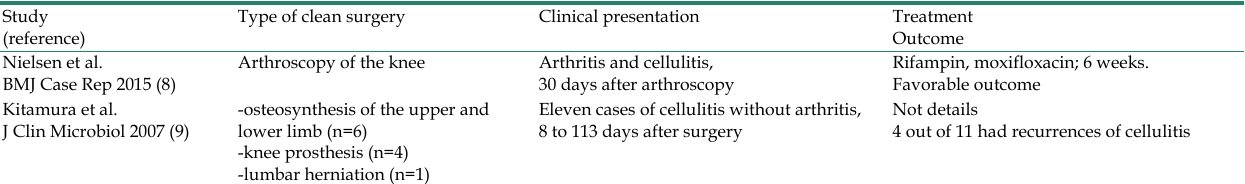
Table 2: Cases of postoperative Helicobacter cinaedi infections after orthopedic surgery in immunocompetent patients. Study